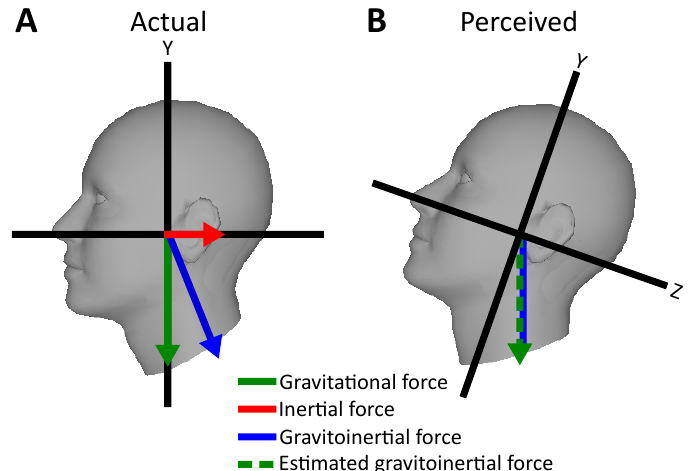
Figure 3. The somatogravic illusion. ( A ): Inertial (red arrow) and gravitational (green arrow) forces are combined in vector sum indicating gravitoinertial force (blue arrow). ( B ): When cues that help decomposing the vector sum are absent, gravitoinertial force is interpreted to be due to the gravitational force (superimposed green and blue arrows) leading to false head pitch perception. Figure adapted from